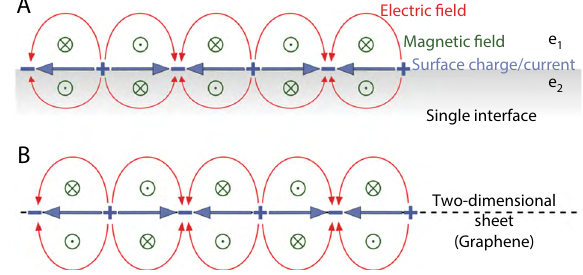
Magnetic field Surface charge/current